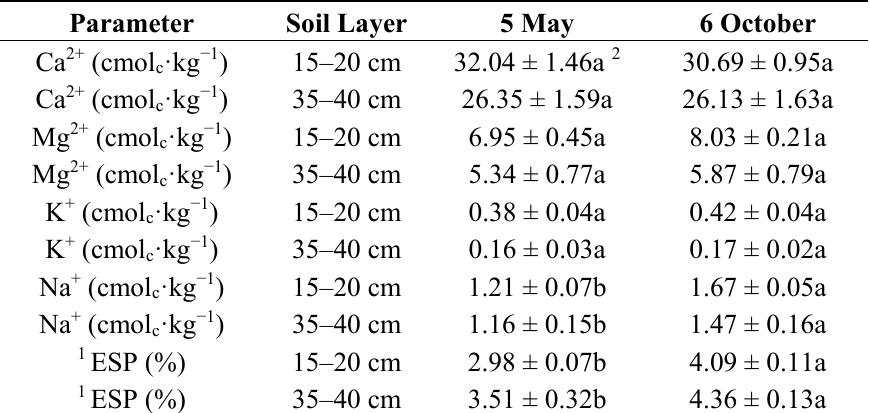
Table 3. Comparison of exchangeable cations concentrations and ESP before (5 May) and after (6 October) the growing